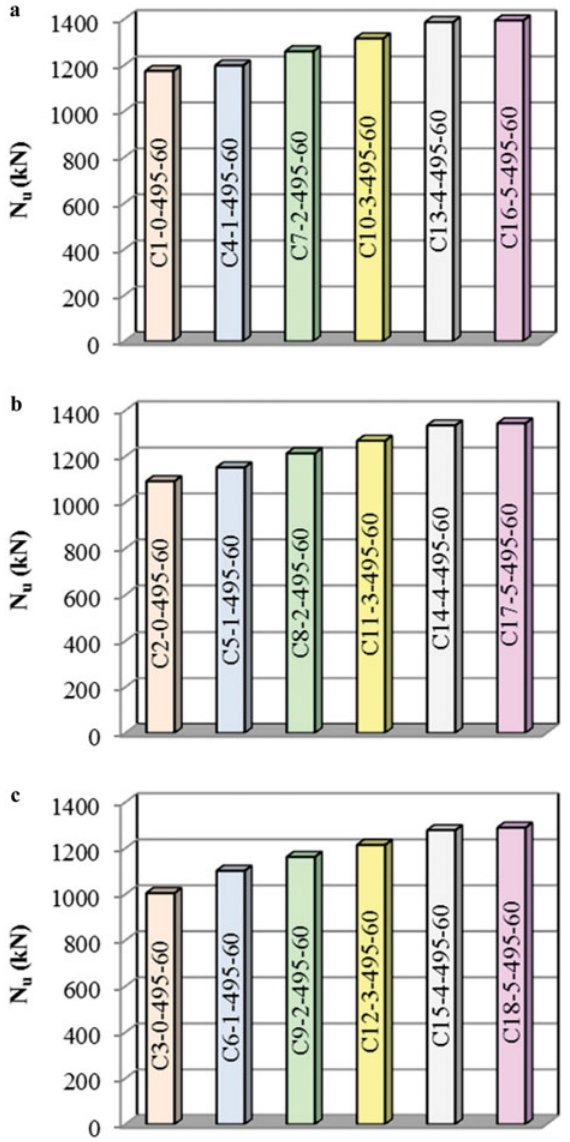
Fig. 7. Effect of tapered angle ( u (cid:4) 0 8 (cid:2) 2.75 8 ) on ultimate axial load capacity: (a) t (cid:4) 4 mm, (b) t (cid:4) 3.5 mm, (c) t (cid:4) 3 mm